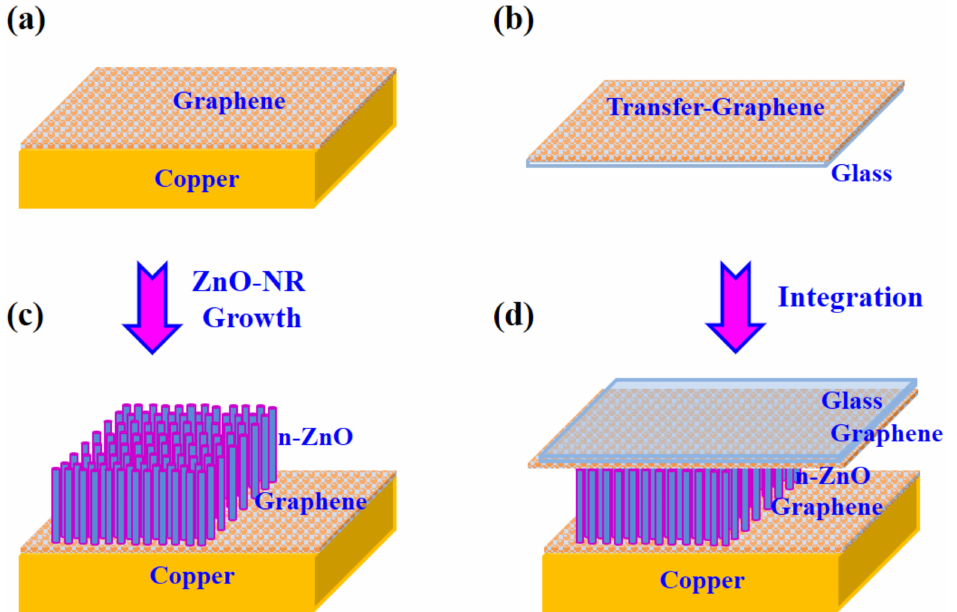
Figure 1. Schematic diagrams of the fabrication process for the graphene/ZnO NRs (nanorods)/graphene hybrid-structure: ( a ) Large-scale graphene prepared by the CVD (chemical-vapor-deposition) on Cu sheet; ( b ) Mono-layer graphene layer transferred to a glass substrate; ( c ) The ZnO NRs growth on the graphene/Cu sheet by the VPT (vapor-phase transport) method; ( d ) Integration of the ZnO NRs/graphene/Cu sheet with the graphene/glass substrate.